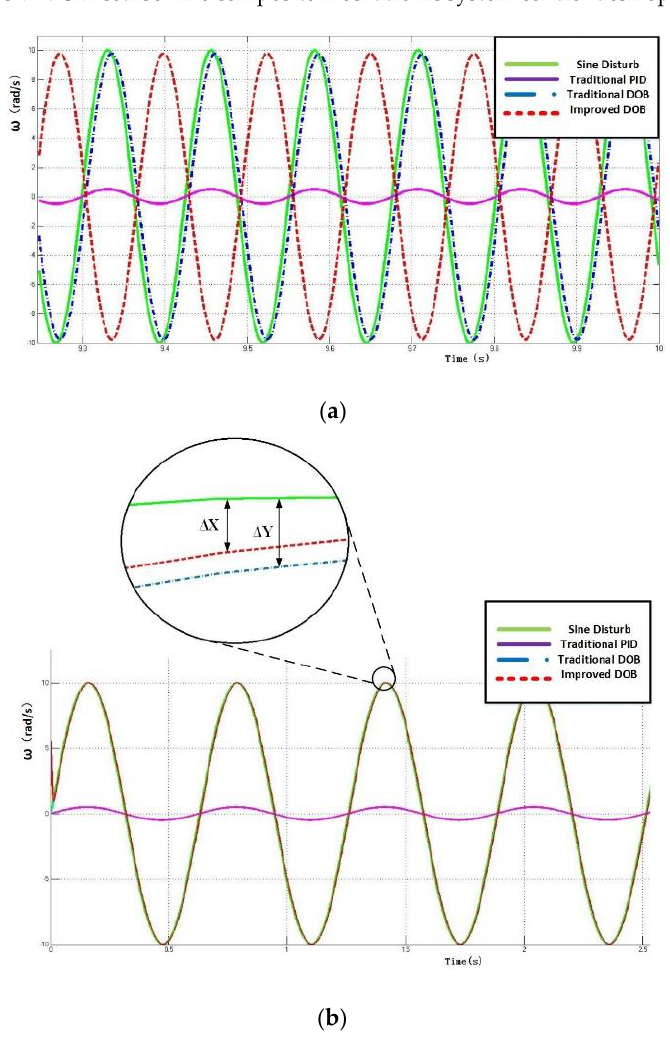
Figure 19. Disturbance suppression output. ( a ) The original curve, ( b ) The enlarged curve.